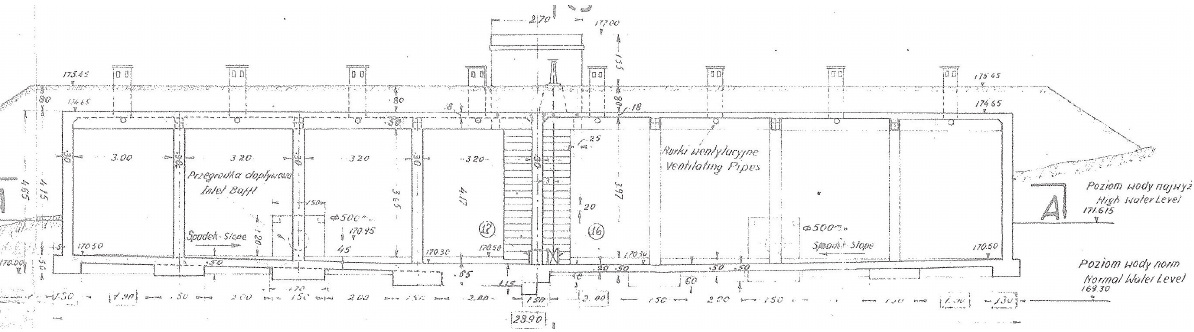
Figure 4: The original design drawing of tank cross section